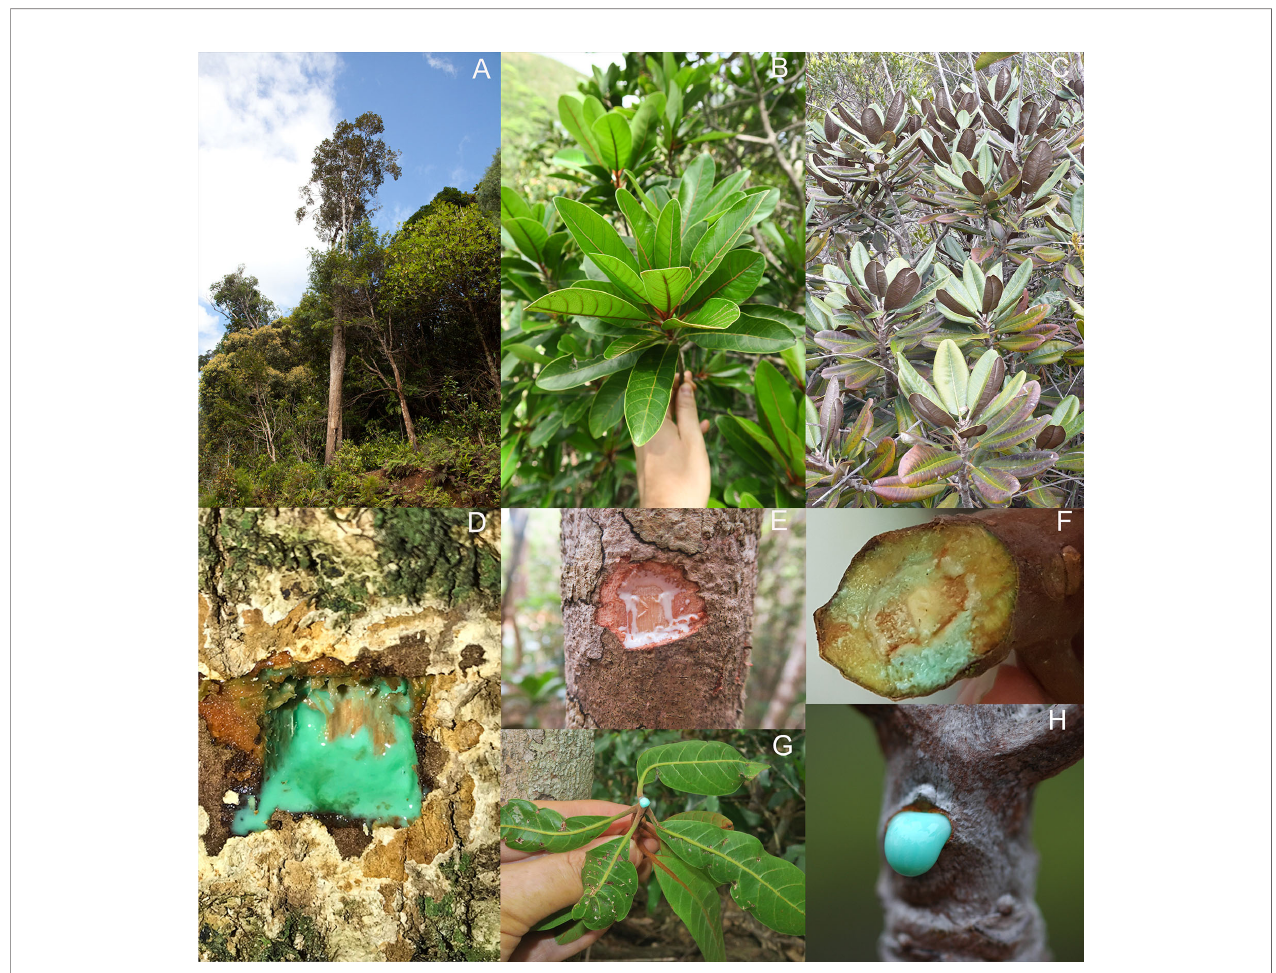
FIGURE 1 | Hyperaccumulator species in the genus Pycnandra (Sapotaceae) from New Caledonia. All three species have a blue-green Ni-rich latex. (A) Mature specimen of Pycnandra acuminata with a tree height of approximately 24 m in the Parc de la Rivière Bleue. (B) Individual of P. caeruleilatex in Kuebini, Yate. (C) Individual of P. kouakouensis in Mount Kouakoue ́ . Green-blue Ni-rich latex exuding from the main trunk of Pycnandra acuminata (D) , white Ni-poor latex exuding from the main trunk of P. caeruleilatex (E) , green-blue Ni-rich latex exuding a small cut branch of P. caeruleilatex (G) , green-blue Ni-rich latex exuding a small cut branch and broken petiole of P. kouakouensis in (F – H)